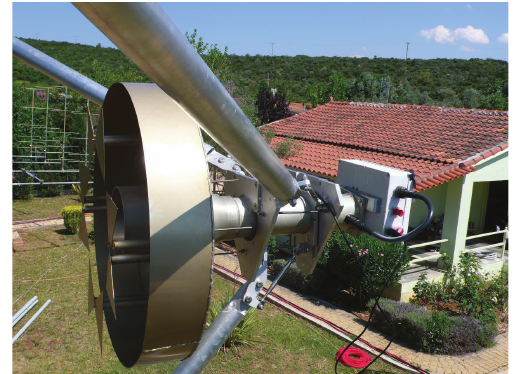
Figure 14: Prototype of the feed installed at the focus of a 6.4 m dish.